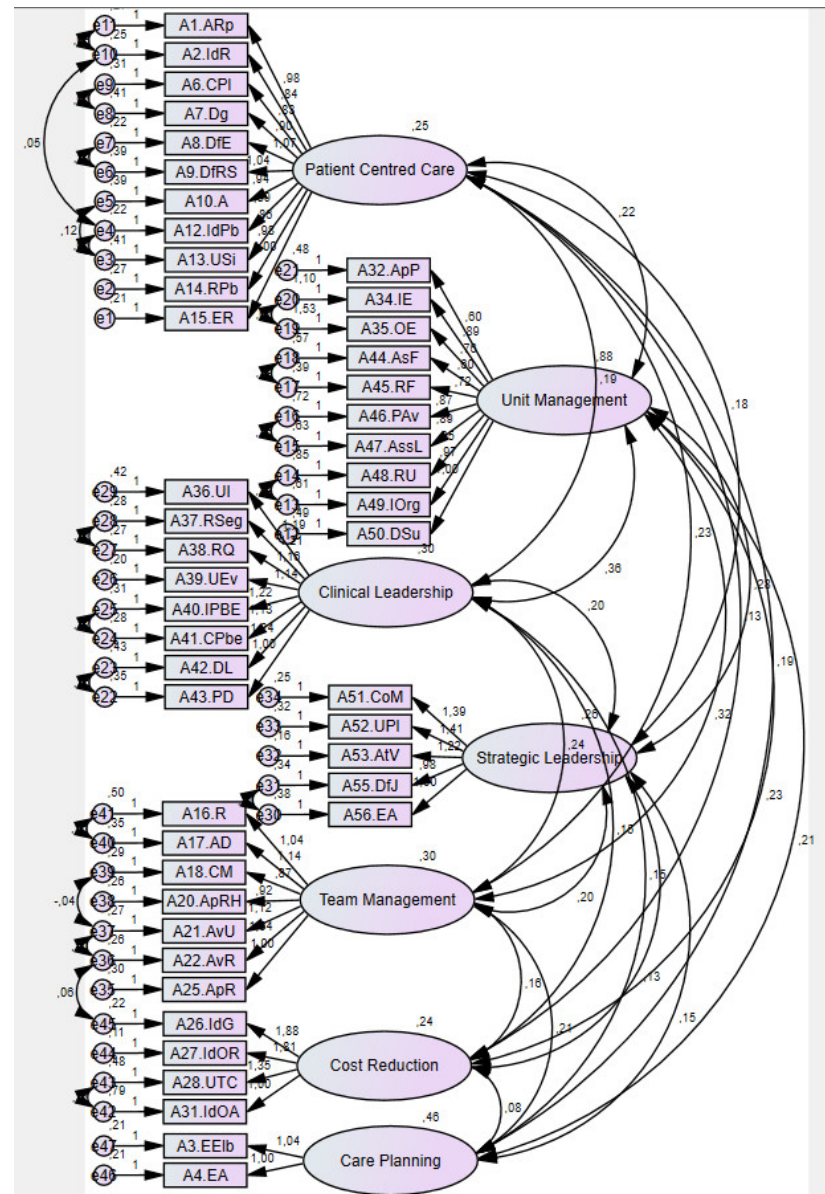
Figure 1. Septa-factorial model of SESCNL-PT for the Portuguese population .